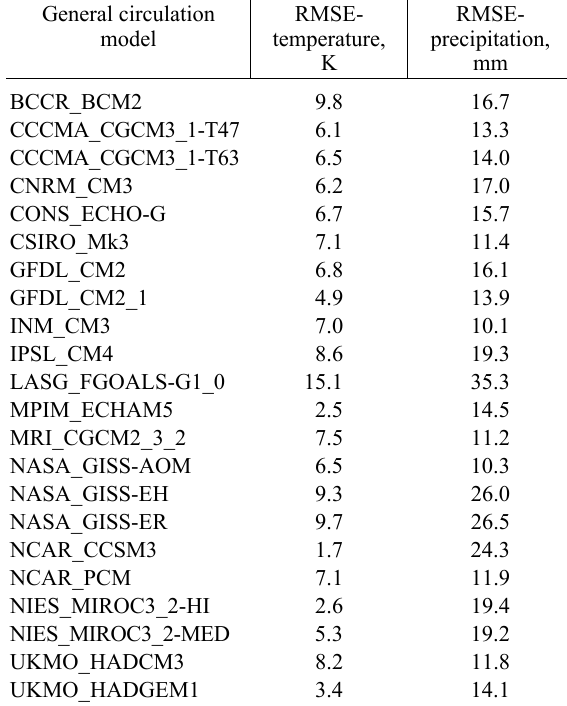
Table 2. Root-mean-square errors (RMSEs) of monthly mean air temperature and precipitation calculated between the modelled for AR4 and the observed monthly mean values for